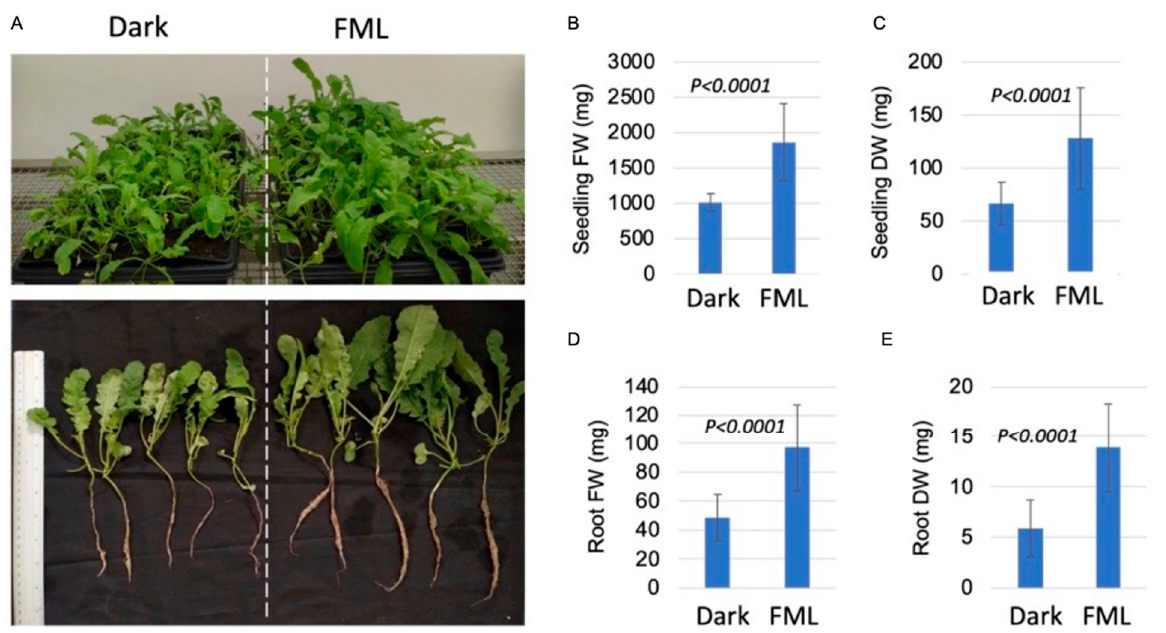
Figure 4. Exposure of B. juncea seedlings to FML enhances their growth. Ten-day-old seedlings were subjected for 3 consecutive nights to 5 h of FML (starting a day before the FM), after which seedlings were placed in a growth room, and their growth was recorded after 2 weeks. ( A ) The appearance of FML- and dark-treated seedlings, 2 weeks after treatment. ( B ) Average seedling fresh weight (FW). ( C ) Average seedling dry weight (DW). ( D ) Average root FW. ( E ) Average root DW. Vertical bars represent the standard deviation ( n = 50). p value was determined using Student’s unpaired t -test using GraphPad software.